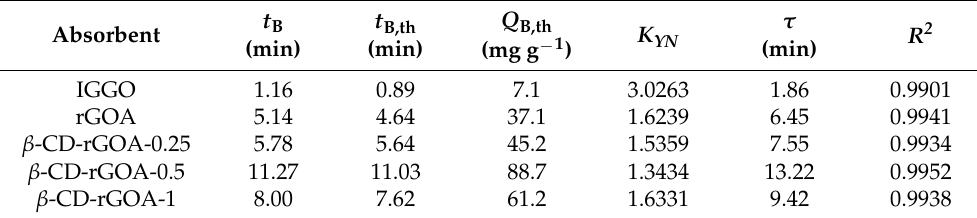
Table 2. Adsorption parameters of different adsorbents for L2 a .